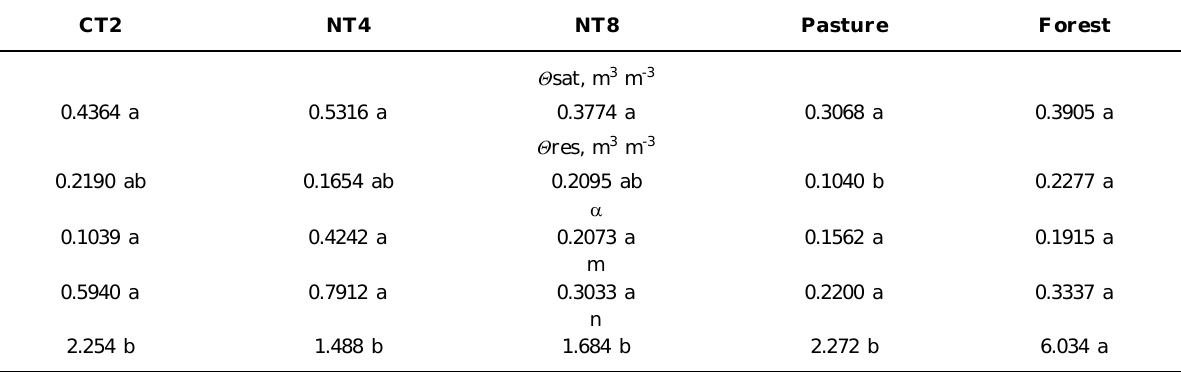
(1) Means of the areas followed by the same letter did not differ from each other by the Tukey test at 5 % (n=105).